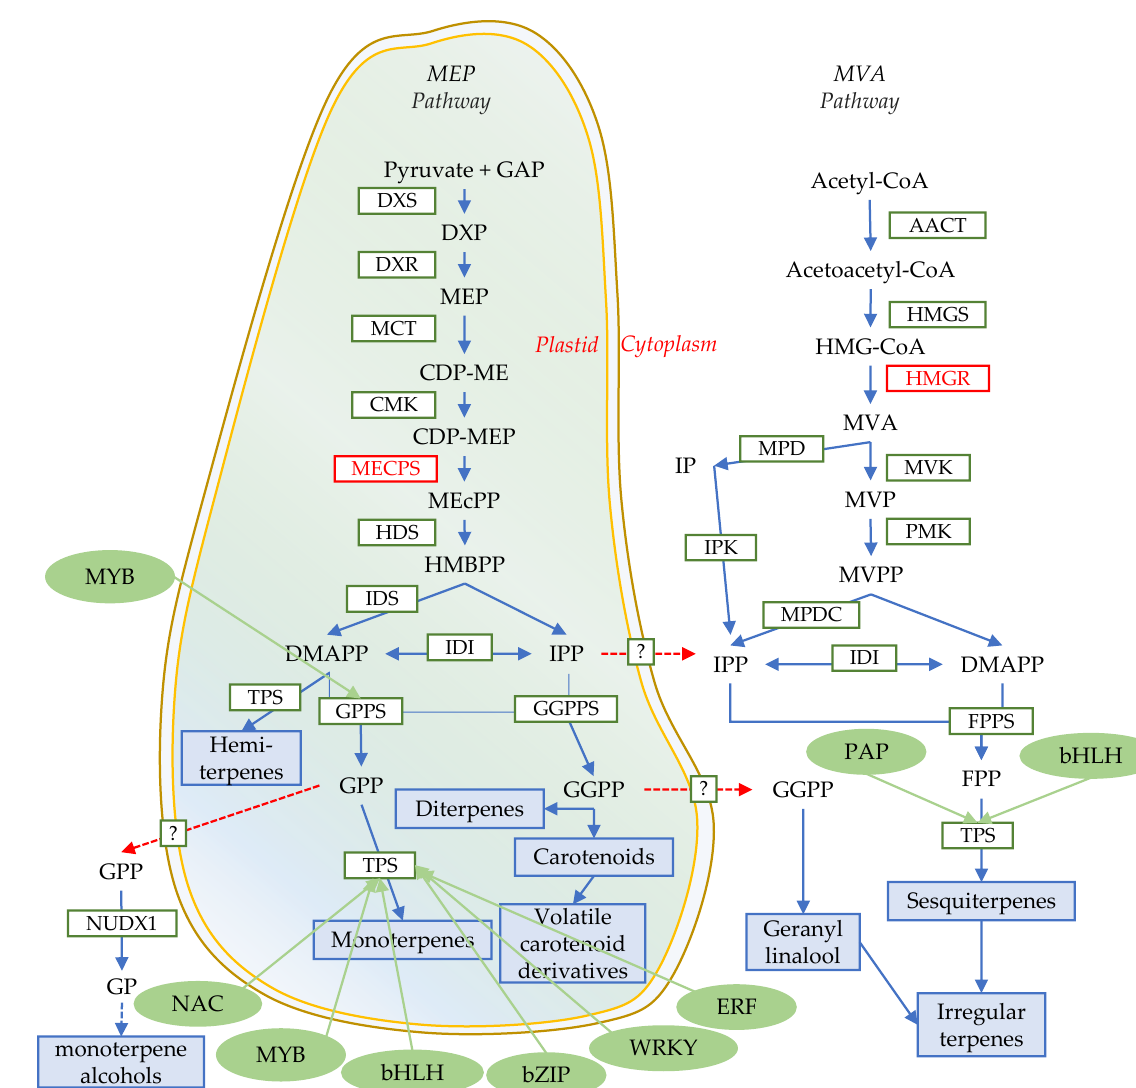
Figure 1. Biosynthesis and regulation of FVT production (adapted from [113,176]). Enzymes are placed in the green frame. Specialized terpenoids are in the blue frame. Dashed lines indicate multiple enzymatic steps and the transport of metabolites between cell compartments. Metabolites acting as signaling molecules are indicated in red. Unidentified transporters are indicated with question marks. Some transcription factors that interact with enzymes in the biosynthetic pathways are indicated with green boxes and arrows. The location of transcription factors in this illustration does not represent their subcellular location. Abbreviations: AACT, acetyl-CoA acetyltransferase; CDP-ME, 4-diphosphocytidyl-2-C-methyl-d- erythritol; CDP-MEP, 2-phospho-4-(cytidine 5 (cid:48) -diphospho)-2-C-methyl-d-erythritol; CMK, 4-(cytidine 5 (cid:48) -diphospho)-2-C- methyl-d-erythritol kinase; DMAPP, dimethylallyl pyrophosphate; DXP, 1-deoxy-d-xylulose 5-phosphate; DXR, 1-deoxy- D-xylulose 5-phosphate reductoisomerase; DXS, DXP synthase; FPP, farnesyl diphosphate; FPPS, farnesyl diphosphate synthase; GAP, D-glyceraldehyde 3-phosphate; GGPP, geranylgeranyl diphosphate (C20); GGPPS, GGPP synthase; GPP, geranyl diphosphate; GPPS, geranyl diphosphate synthase; HDS, 4-hydroxy-3-methylbut-2-en-1-yl diphosphate